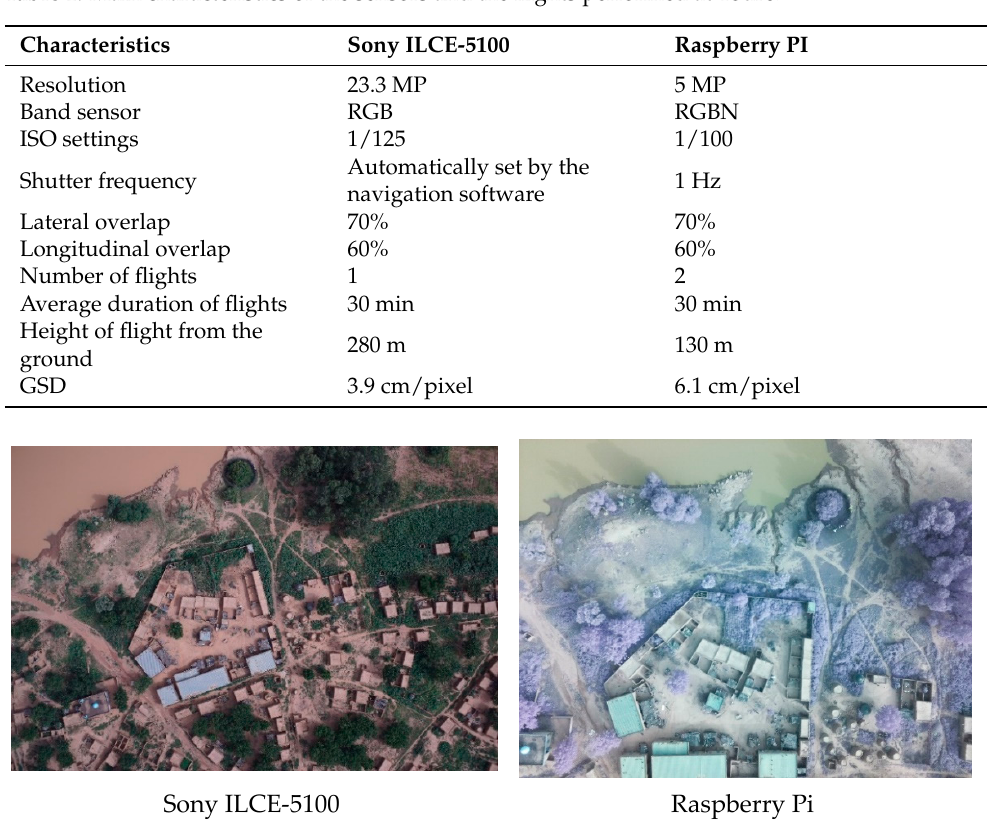
Table 1. Main characteristics of the sensors and the flights performed at Tour è .